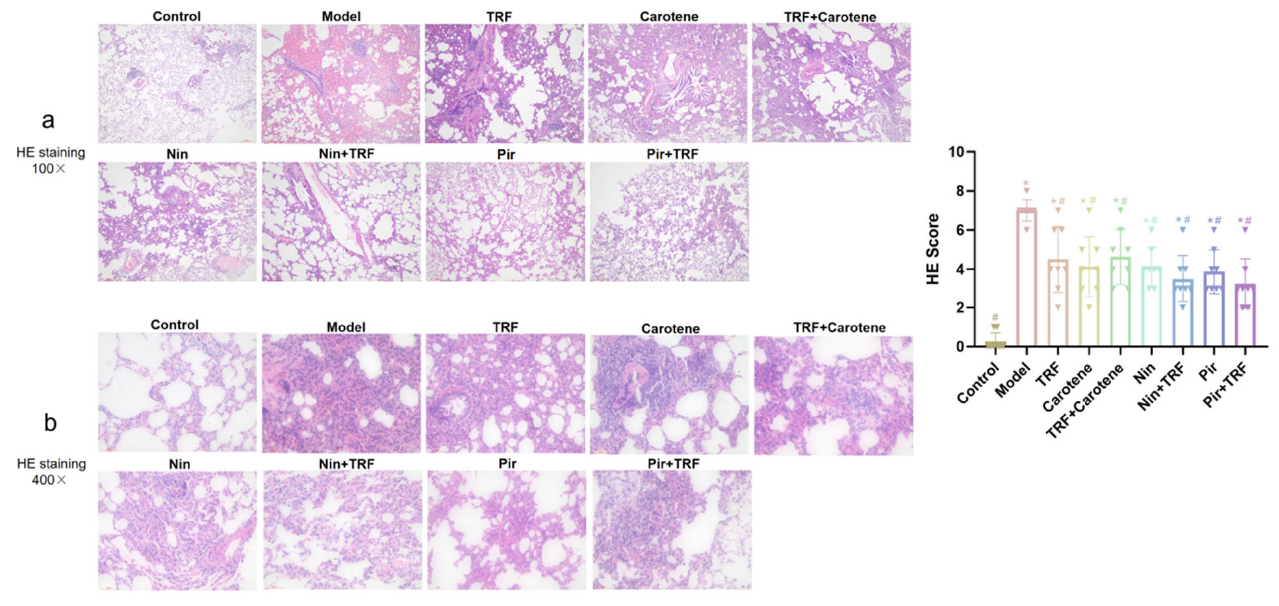
Figure 5. Effects on lung histopathological changes of TRF in H&E ‐ stained specimens: Lungs from the different groups of rats were collected, and 4 ‐μ m thick sections were prepared and used for the assessment of tissue injury; ( a ) original magnification: 100×; ( b ) original magnification 400×; n = 8. Note: * represents p < 0.05 in comparison to the control group; # represents p < 0.05 in comparison to the model group.